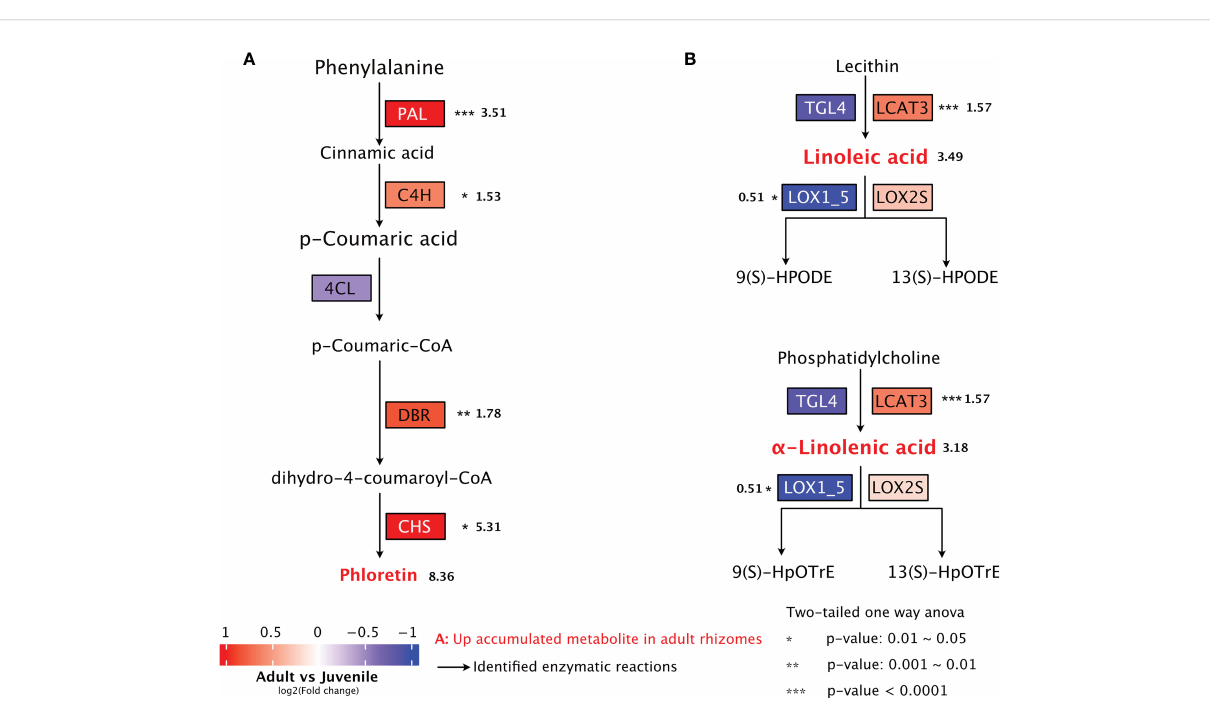
while LOX1_5 and LOX2S could dioxygenate a -linolenic acid into 9(S)-HPODEm or 13(S)-HpOTrE. We found that the expression of LCAT3 is signi fi cantly higher, and the expression of LOX1_5 is signi fi cantly lower in adult rhizomes (Figure 7B).